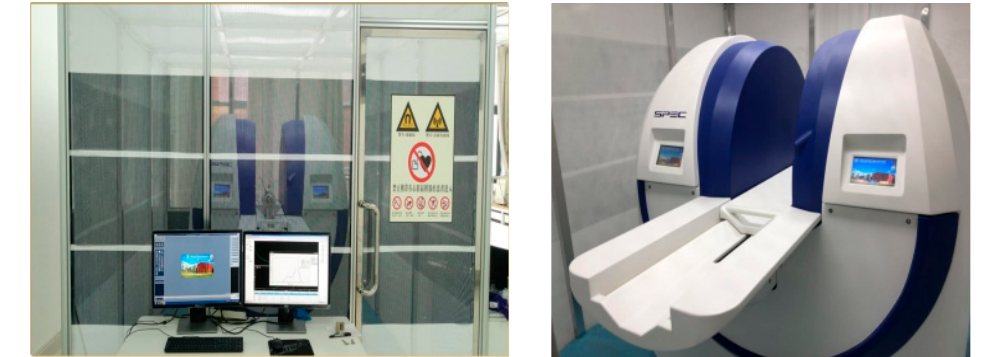
Figure 1. Key experimental equipment .